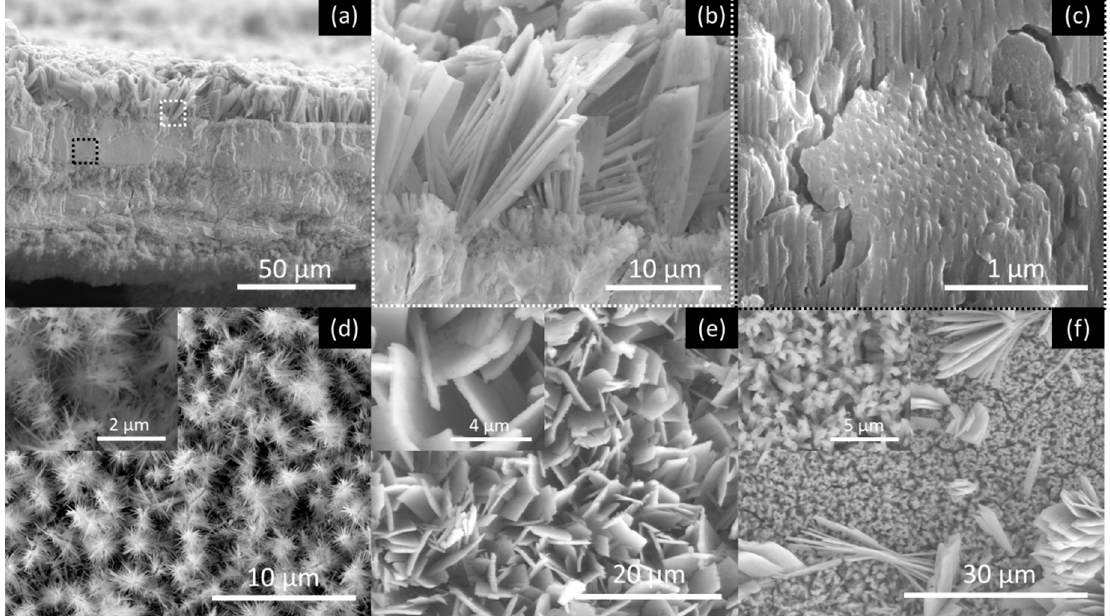
Figure 8. SEM images of the AHO nanostructures after 1 h of anodization for the NMF sample. Cross-section images showing ( a ) the thick oxide layer that contains ( b ) nanoflakes at the layers’ top and ( c ) self-ordered nanoporous structures (zone areas where ( b , c )) images where extracted from ( a ) images are indicated; top view shows ( d ) nanoneedles (inset at higher magnification) ( e ) nanoflakes (inset at higher magnification) and ( f ) nanowires-agglomerations (inset at higher magnification), all present in this sample.